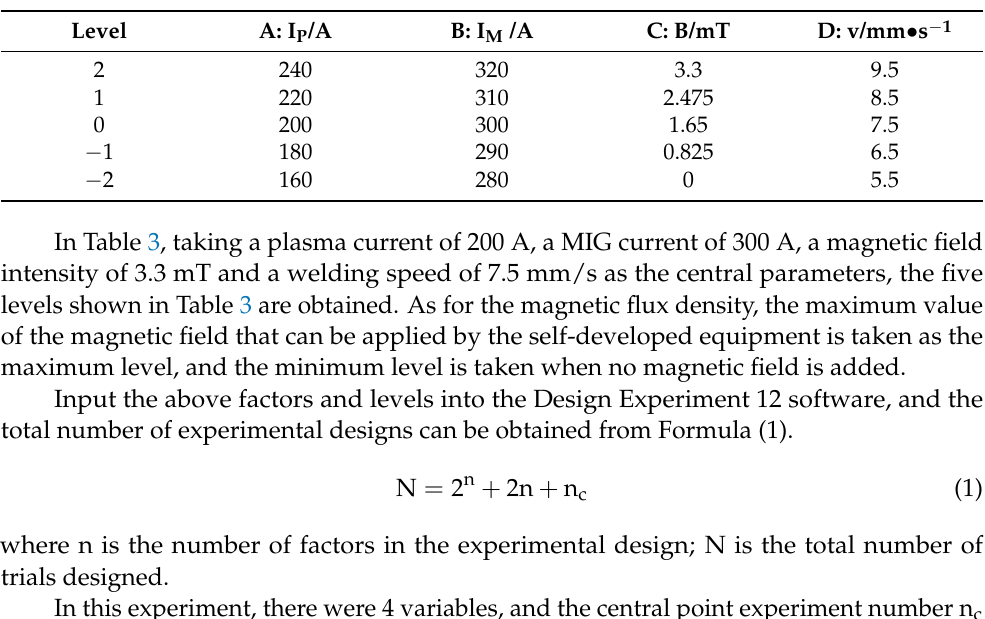
Table 3. Test factors and level comparison table (Alpha =